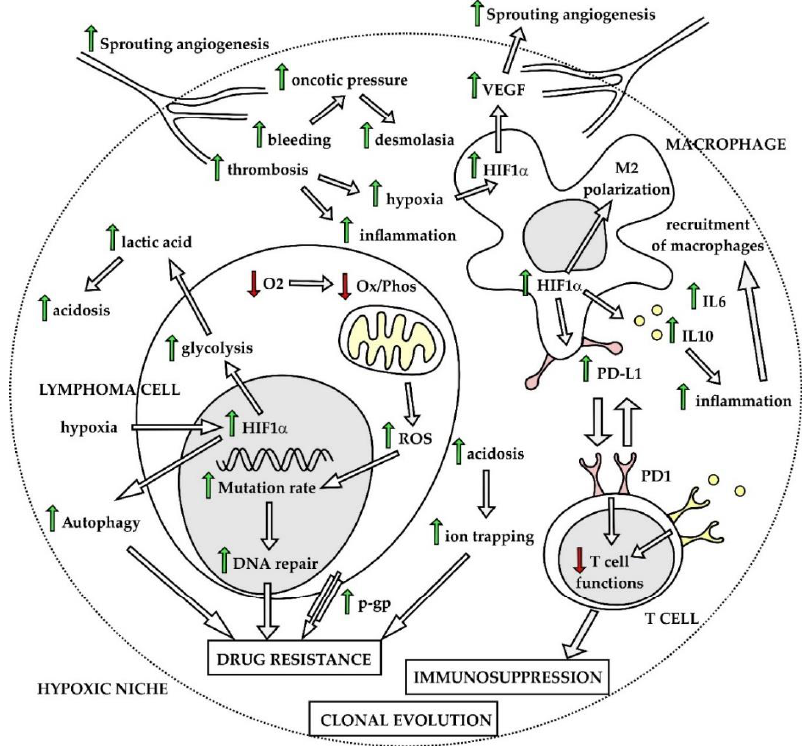
Figure 4. Hypoxic niche. Ox / Phos—oxidative phosphorylation, HIF1—hypoxia-inducible factor 1, PD1—programmed death 1, PD-L1—PD ligand 1, VEGF—vascular endothelial growth factor, O 2 —oxygen, ROS—reactive oxygen